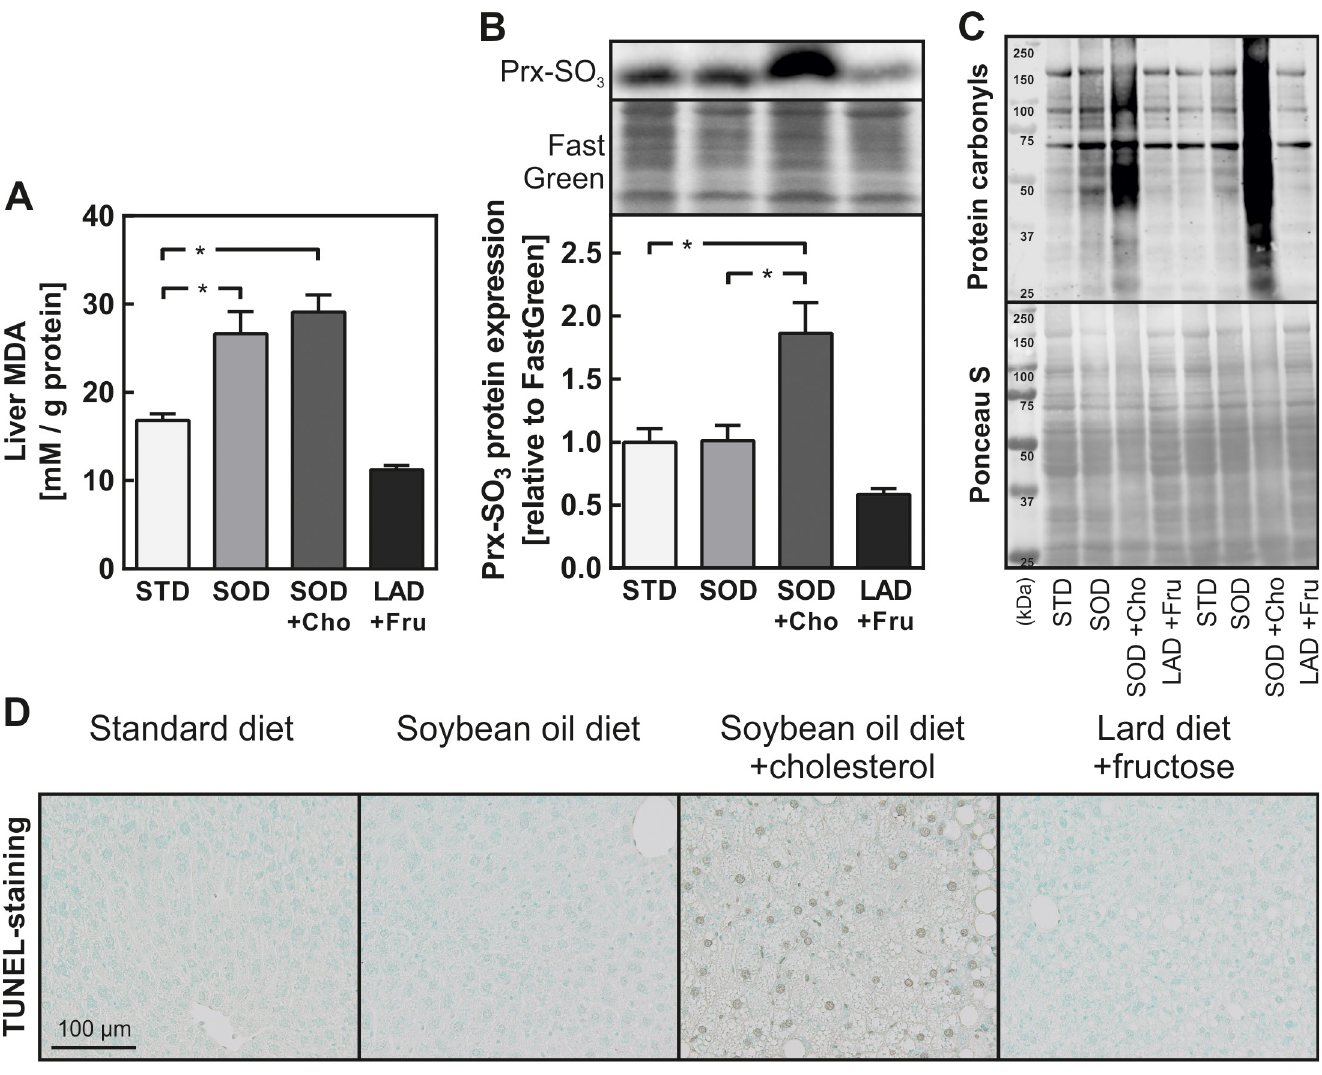
Figure 2. Dietary soybean oil diet increased hepatic lipid peroxidation, but only soybean oil diet + cholesterol provoked oxidative stress and apoptosis in mouse livers. Mice received diets as described in Figure 1. (A) Lipid peroxidation: malondialdehyde relative to protein content in liver homogenates. (B,C) Oxidative stress: hyperoxidized peroxiredoxins (Prx-SO , B) were determined in liver lysates by Western 3 blot analysis with a specific antibody and normalized to Fast Green staining, which was verified on the same Western blot membrane as a loading control. Carbonylated proteins were verified by oxyblot with (C) ponceau S staining as a loading control. (D) Apoptosis: DNA damage in apoptotic cells was visualized by TUNEL staining. Values represent (A,B) means ± standard error of the mean of 5 mice per group or (C,D) representative photographs. Statistics: (A,B) One-way analysis of variance with Dunnett’s post hoc test or, where appropriate, Tukey’s post hoc test for multiple comparisons, *p